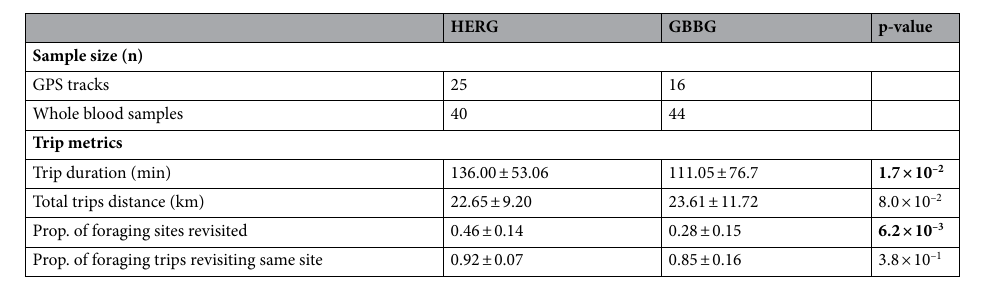
Table 1. Summary of samples sizes and trip metrics with associated p-values from statistical comparisons of GPS tracking data for herring gulls (HERG) and great black-backed gulls (GBBG). Differences in trip metrics between species were tested using a Wilcoxon-rank sum test. Significant differences are shown in bold (α ≤ 0.05).